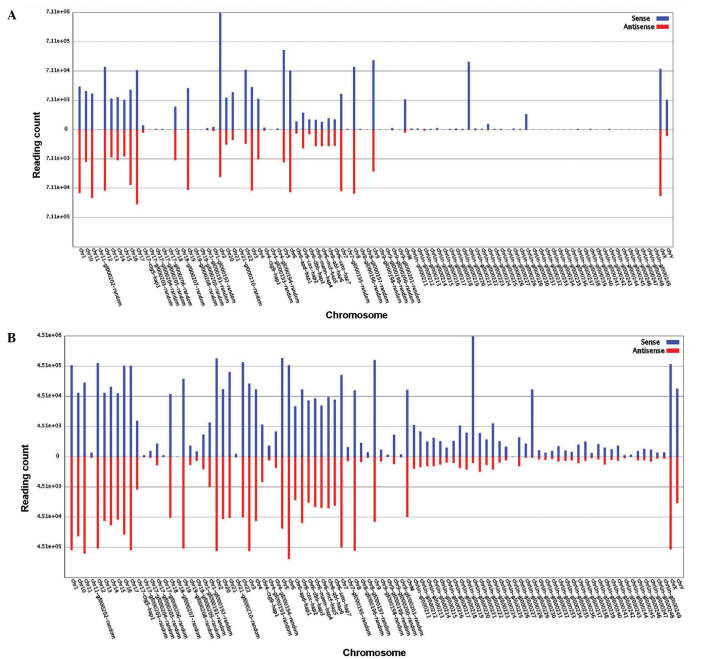
Number of small RNA tags that were located on each chromosome in the (A) membranous nephropathy (MN) and (B) normal control (NC) groups. The area above 0 is the number of small RNAs on the sense strand of the chromosome, shown in blue. The area below 0 is the number of small RNAs on the antisense strand of the chromosome, shown in red.